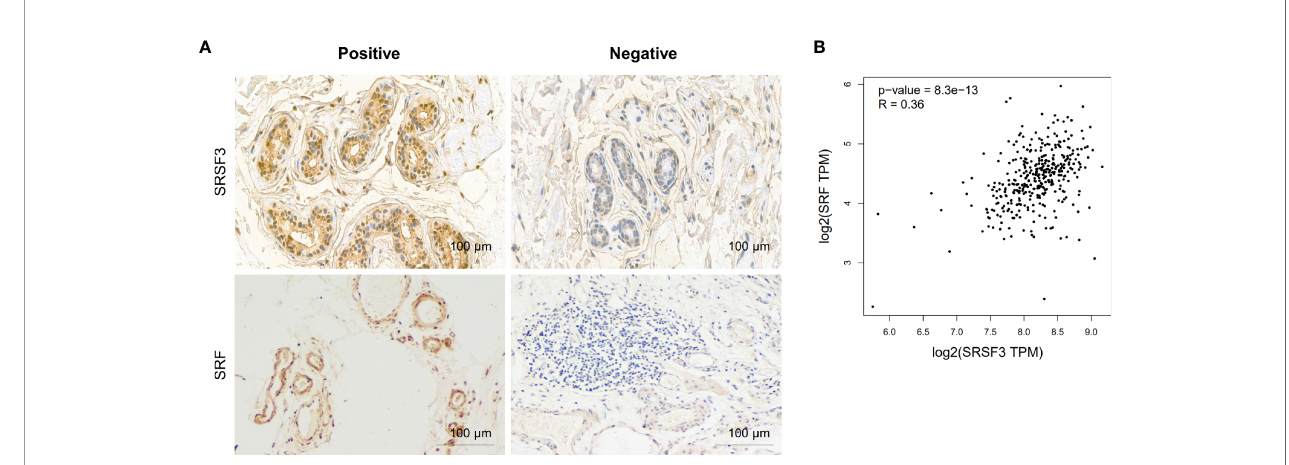
FIGURE 3 | The expression of SRSF3 and SRF in CRC. (A) IHC staining of the SRSF3 and SRF proteins in endothelial cells around blood vessels ( n =55). (B) The correlation between SRSF3 and SRF mRNA expression in TCGA